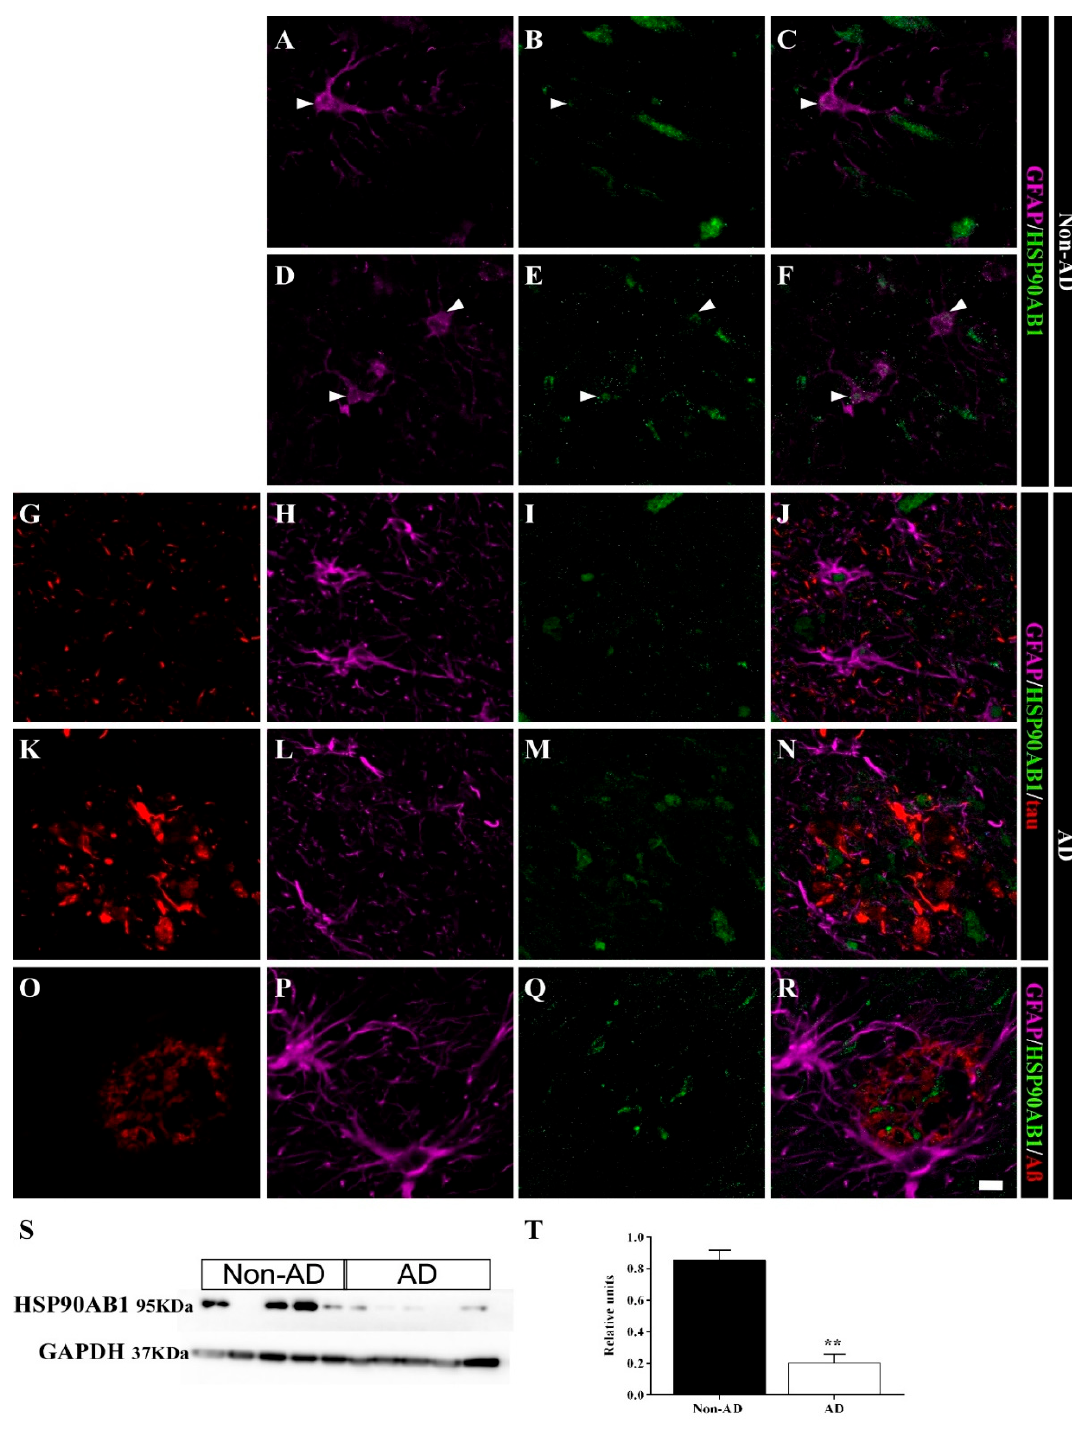
Figure 7. HSP90AB1 is colocalized with astrocytes in the human HIPP. Confocal analyses of GFAP ( violet ), HSP90AB1 ( green ) and tau or A β ( red ) expression in the CA1 region in non-AD ( A – F ) and AD ( G – R ) samples. In non-AD cases, HSP90AB1 was observed in astrocytes ( arrowhead ) ( A – F ). In AD samples, HSP90AB1 was found in plaque core, but was not expressed in astrocytes in the vicinity ( N , R ). However, isolated astrocytes showed a similar expression pattern between AD samples and non-AD samples ( J ). HSP90AB1 expression throughout the whole human HIPP was evaluated by WB ( S , T ) (the graph shows the mean ± SEM, ** p value < 0.01). Scale bar = 10 µm.